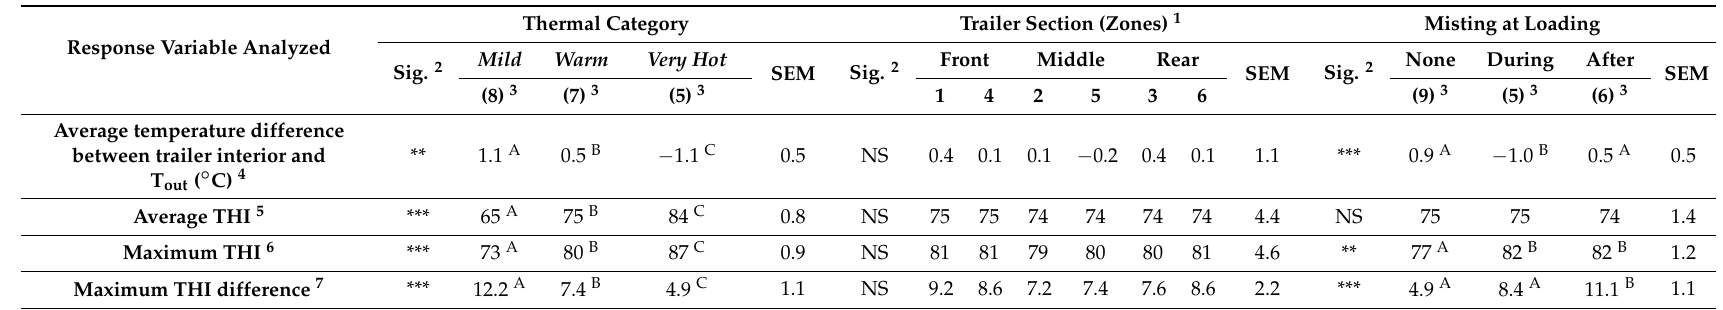
1 Trailer zones are designated as: zone 1—top front; zone 4—bottom front; zone 2—top middle; zone 5—bottom middle; zone 3—top rear; and zone 6—bottom rear. 2 Sig. indicates level of significance for the main effect, where ** indicates a p -value < 0.01, *** indicates a p -value < 0.001, and NS is not significant ( p > 0.05). 3 Numbers in the parenthesis indicate the number of trips completed and analyzed for this combination. 4 Numbers indicate the least square means for the average temperature difference between trailer interior and the outside temperature for the during transport segment. 5 Numbers indicate the least square means for the average THI for the during transport segment. 6 Numbers indicate the least square means for the maximum THI for the during transport segment. 7 Numbers indicate the least square means for the difference between the maximum THI documented for inside the trailer and the average THI for the outside condition for the during transport segment. A–C Different superscripts within a row under the analyzed factor indicate the means differ significantly ( p < 0.05) using the Tukey–Kramer test for differences of least squares